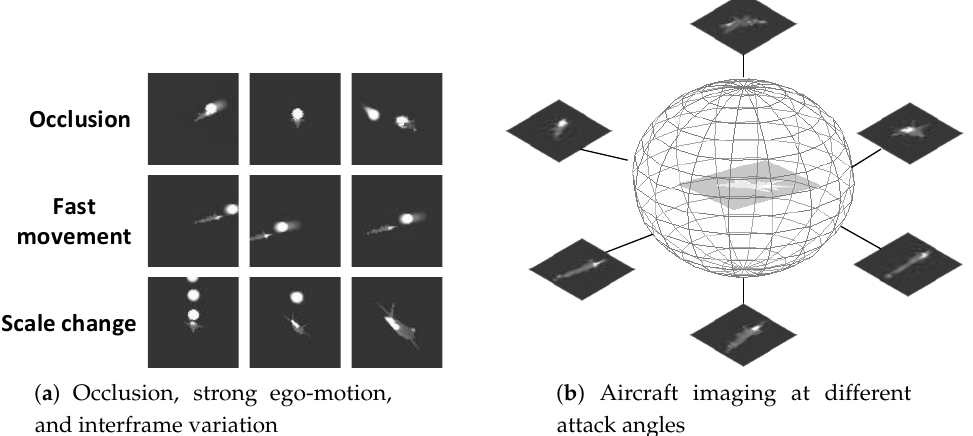
Figure 1. Challenge of aircraft tracking for infrared-imaging